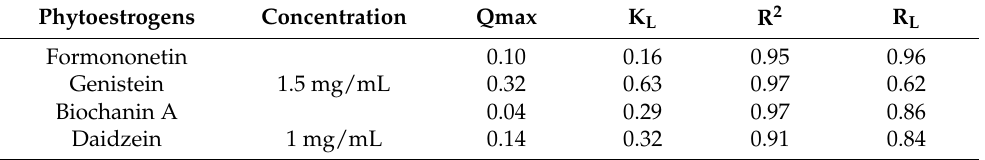
Table 2. Isothermal parameters of the phytoestrogens treated with the purified E. hirae biopolymer. Figure 2. Langmuir adsorption isotherm for ( a ) daidzein and ( b ) genistein. Mean values obtained from three replicates are shown. Among the isoflavones, i.e., D, F, GE and BCA, and the Q max value of the biopolymer, the saturation concen- tration, i.e., 1 mg/mL and 1.5 mg/mL, was found to be in the following order: daidzein > genistein > biochanin A > for- mononetin, respectively. As K L is related to the energy of the adsorption process, a trend was generated based on the adsorption energy of the phytoestrogens and can be inferred as daidzein > genistein > biochanin A > formononetin.